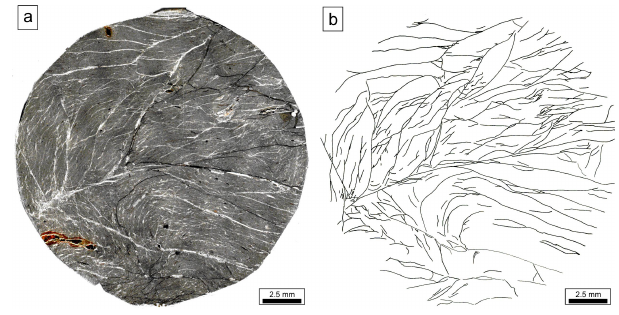
Figure 13. BIB-RLM micrograph and sketch of subsample V12-1 (see Fig. 12 for location). Note the microfold in the lower sample part with bend foliation, while the microlithons in the upper part show a uniform foliation. There is no shear zone overprinting visi-